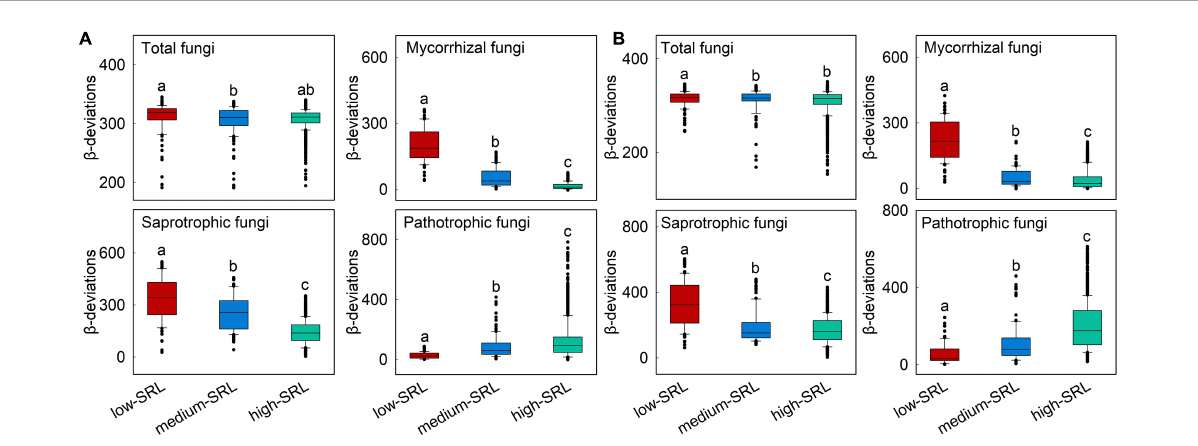
FIGURE4 Variations in β -deviations of mycorrhizal, saprotrophic and pathotrophic fungi across low, medium, and high categories of specific root length (SRL) in surface (A) and subsurface (B) soil. SRL was separated into three categories and correlated with β -deviations within each category. Boxplots that do not share a lower case letter are significantly different ( P < 0.05, Wilcoxon rank-sum test). These three categories were divided based on Supplementary Figure 4 .